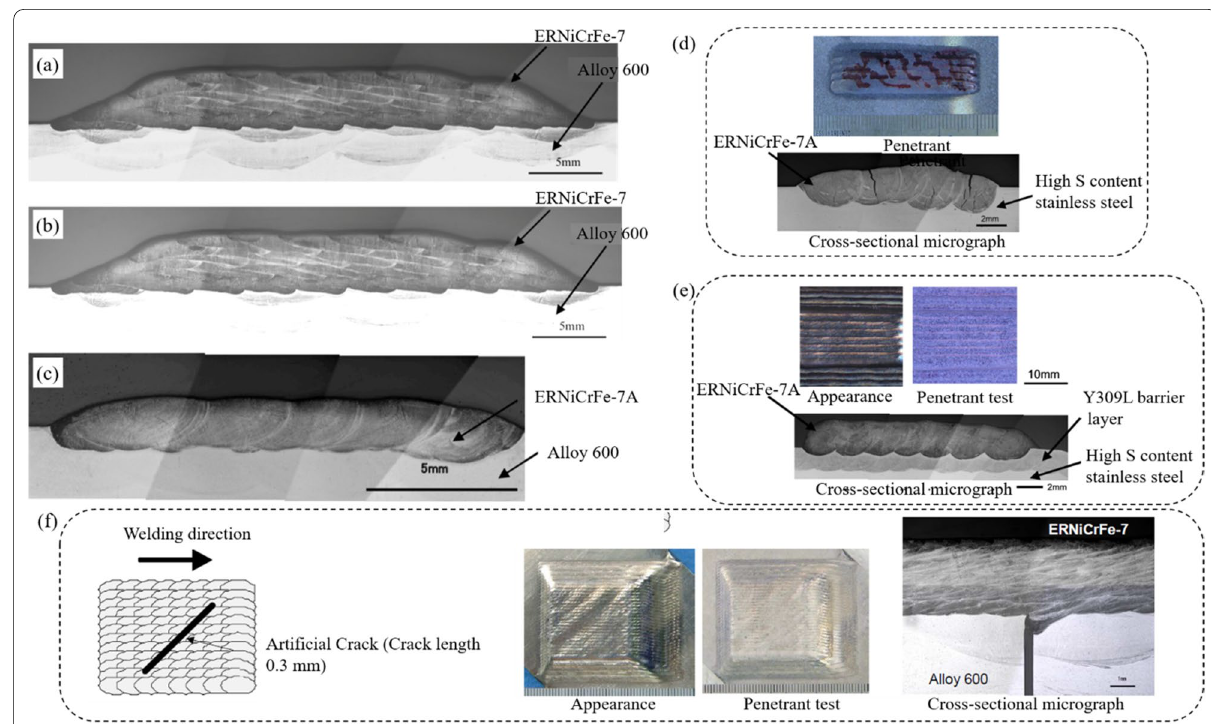
Figure 9 Results from Toshiba in Japan. Cross-sectional micrograph of multi-layered cladding: ( a ) at low deposition rate and ( b) , ( c ) at high deposition rate. Penetrate test result and cross-sectional micrograph of ERNiCrFe-7A cladded layers: ( d ) directly on the high S stainless steel and ( e ) with Y309L as the barrier layer on high S stainless steel, ( f ) Typical bead appearance, penetrant test and cross-sectional micrograph of multi-layered underwater laser seal welding